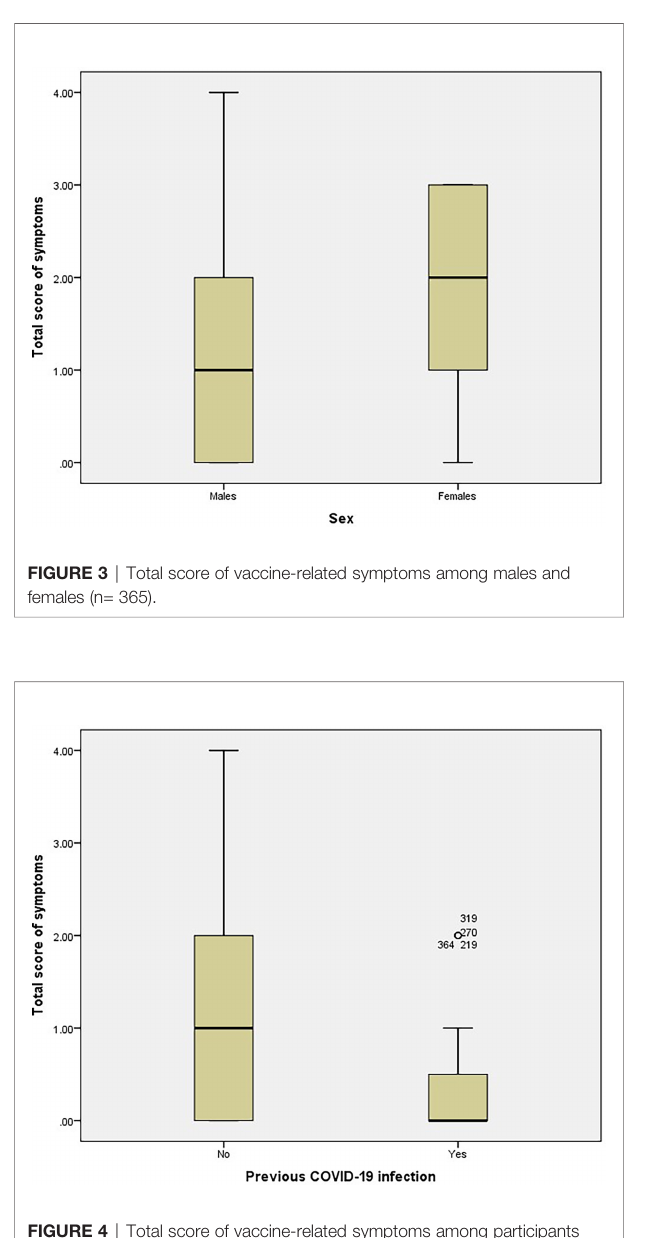
FIGURE 4 | Total score of vaccine-related symptoms among participants with no previous infection and participants with reported previous COVID-19 infection (n=